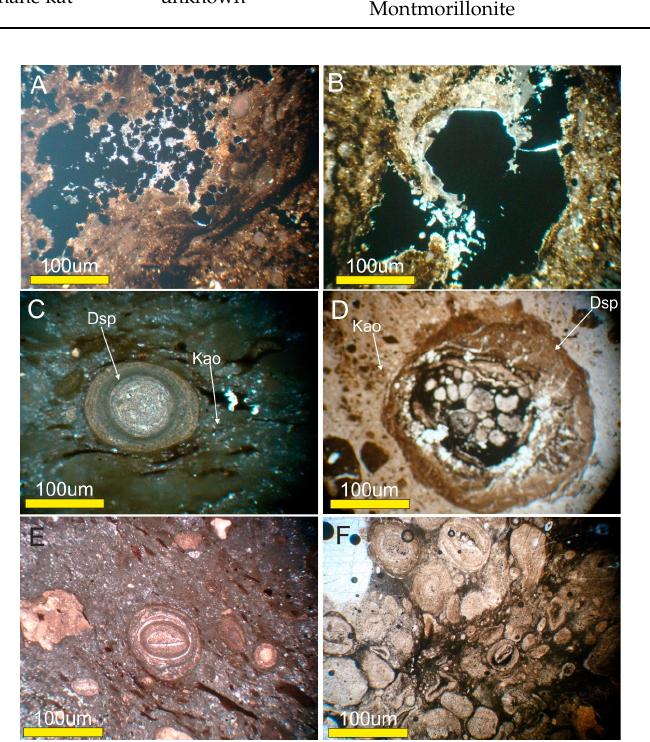
Figure 5. Microphotographs of the Dopolan deposit: ( A ) Euhedral and framboidal pyrite in the iron-rich bauxite; ( B ) Euhedral pyrite in the organic-rich bauxite; ( C ) Diaspore concretion in a porous matrix composed of kaolinite; ( D ) Complex residual rounded fragments typical of pisolitic bauxite; ( E ) Simple pisolite with a kaolinite core surrounded by a preserved cortex of boehmite; ( F ) Discolored pisolites showing deferrification process, kao = kaolinite, Dsp = diaspore.